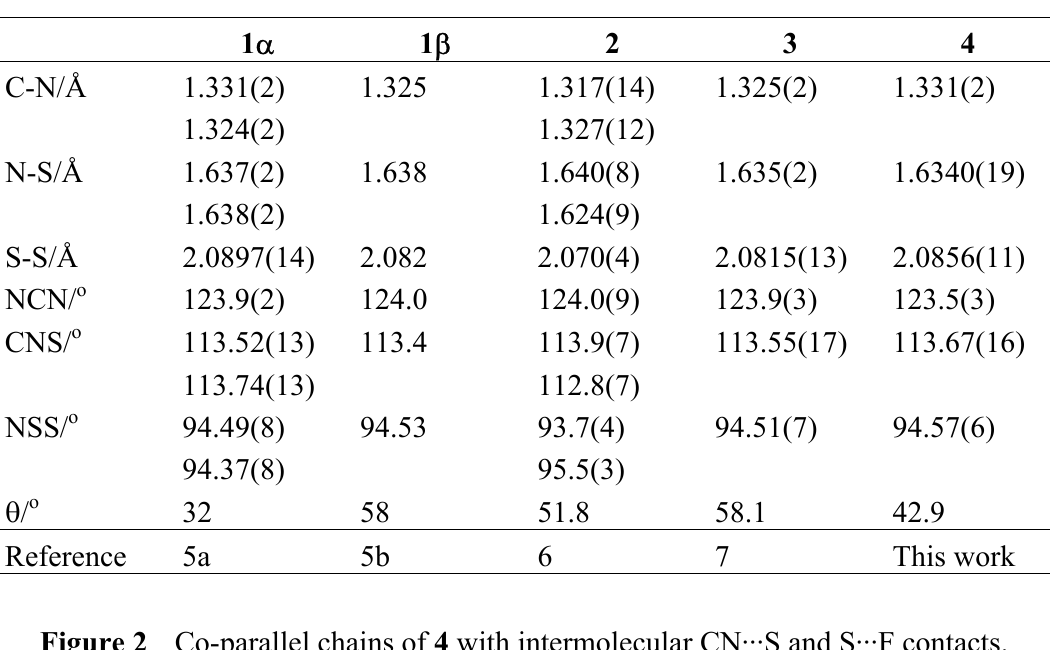
S and C F mean 2 2 6 4